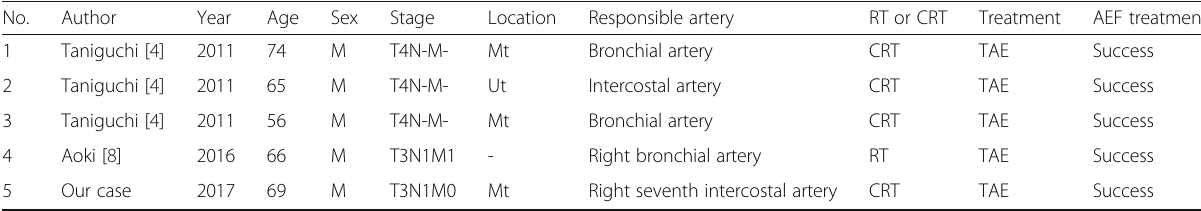
Table 1 Reported cases of non-aortic arterio-esophageal fistula